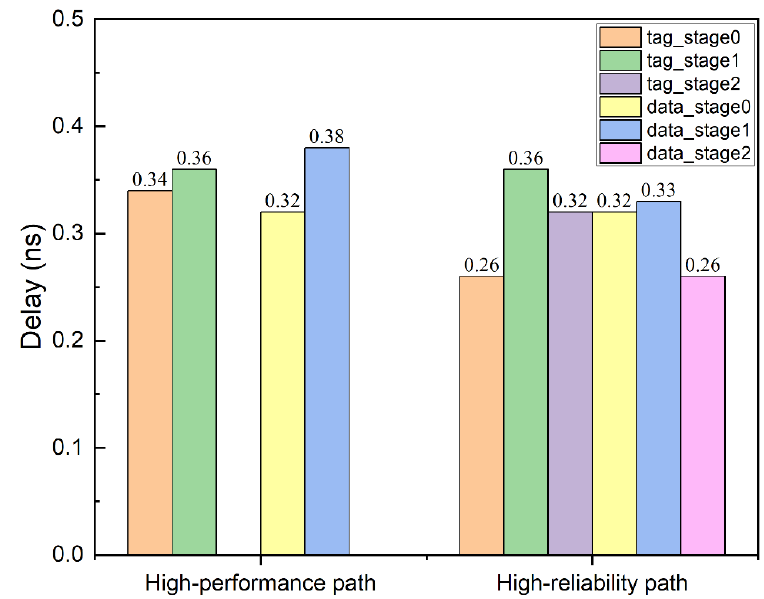
Figure 6. Delay at each stage of the two paths.